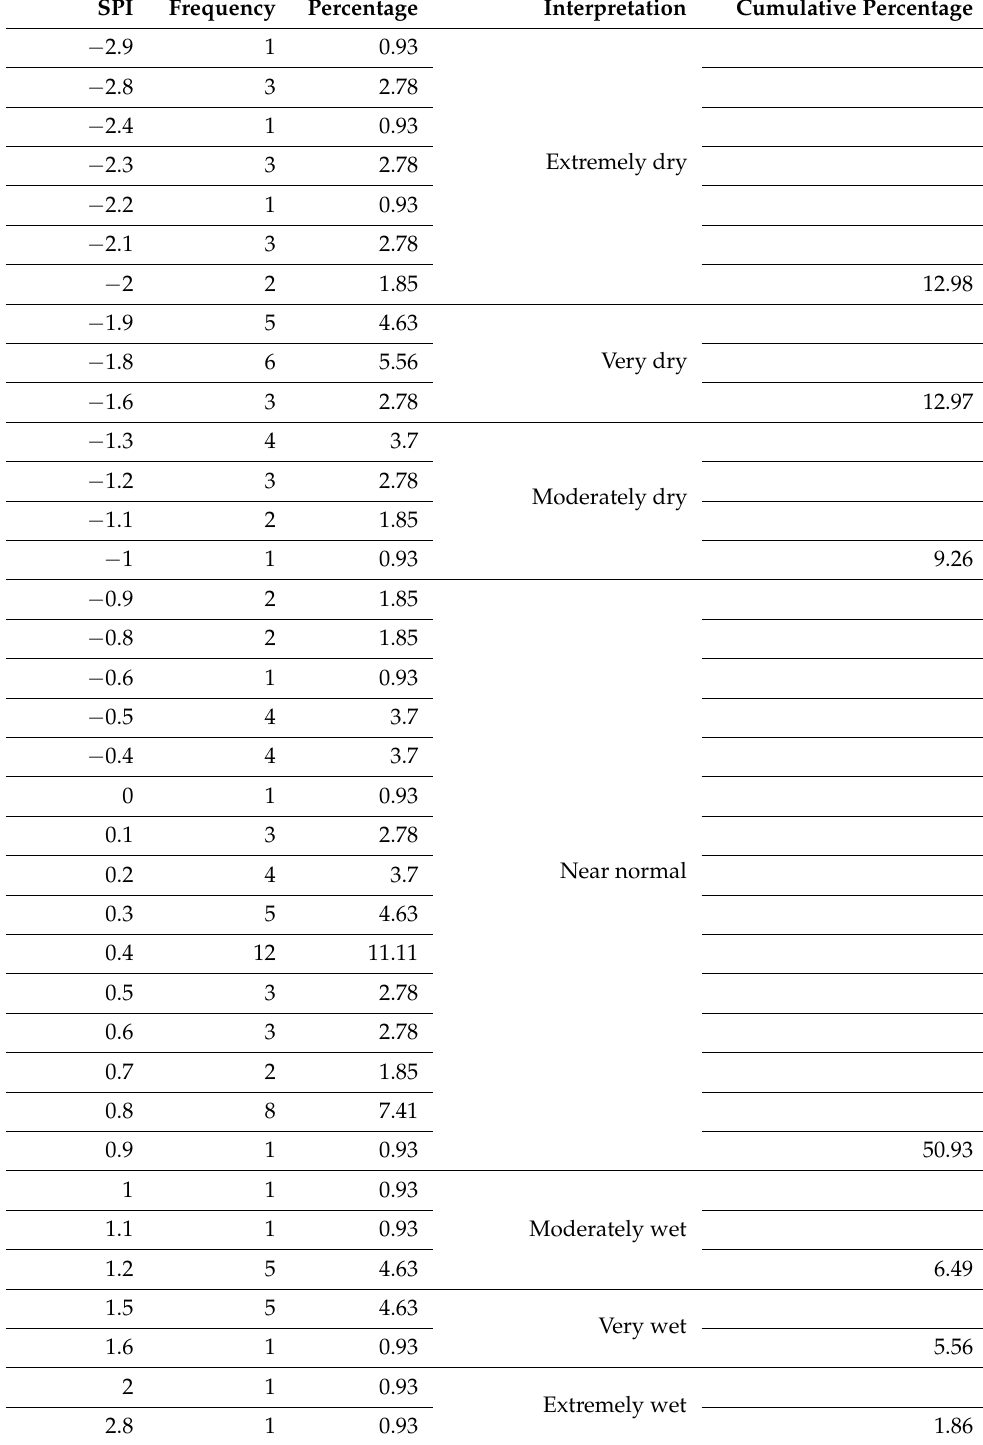
Table 5. Frequency of forecasted Monthly SPI values from 2022 to